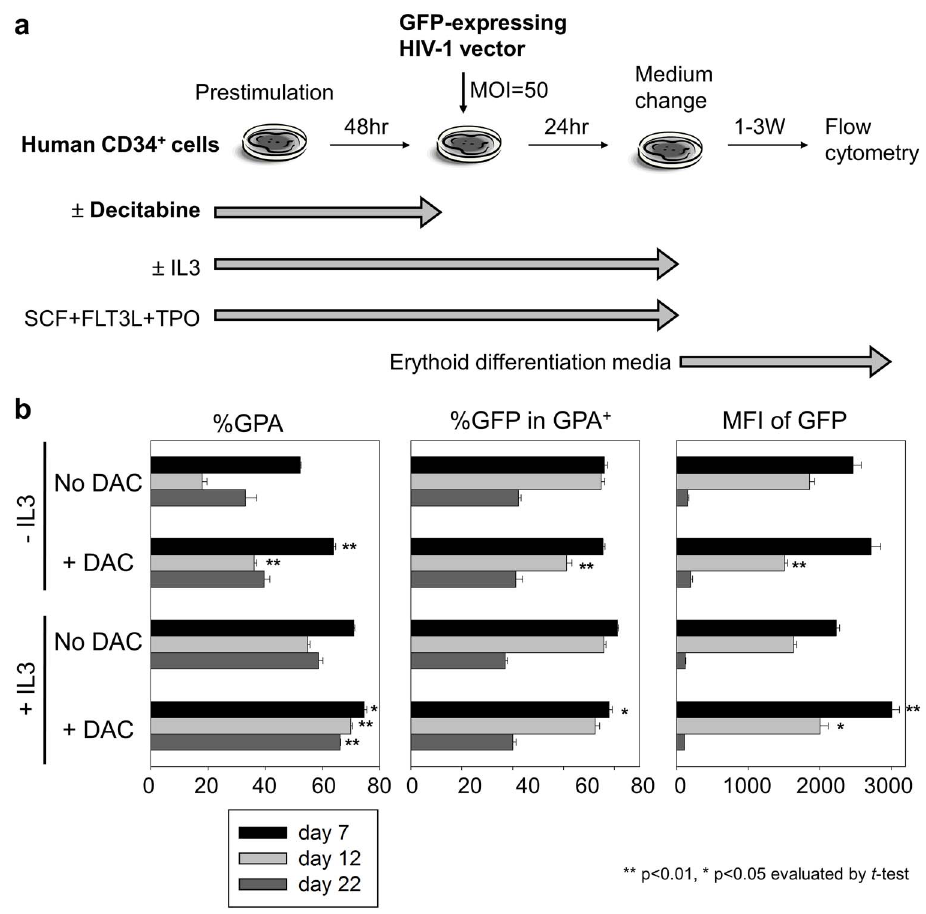
Figure 6. Decitabine promotes efficient erythroid differentiation from transduced CD34 + cells. (a) To evaluate decitabine effects on erythroid differentiation and transduction efficiency, we transduced human CD34 + cells with a GFP-expressing HIV-1 vector following 48-hour prestimulation with 0.5 m M decitabine. After 24-hour transduction (without decitabine), the cells were differentiated into erythroid cells. (b) Both %GFP and GFP intensity in GPA-positive cells gradually decreased during the erythroid differentiation. The glycophorin A-positive rates (%GPA) were increased by decitabine exposure, while equivalent %GFP was observed. We analyzed data in decitabine exposure groups, compared to no decitabine